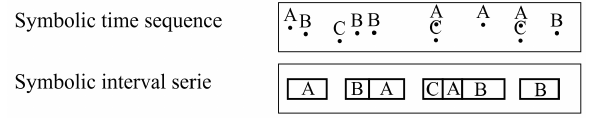
Figure 7: Difference between symbolic time series and symbolic time sequences. While items in a symbolic time series are partially ordered and do not repeat, items in a symbolic time sequence may be co-occurring and repeat as well [29].